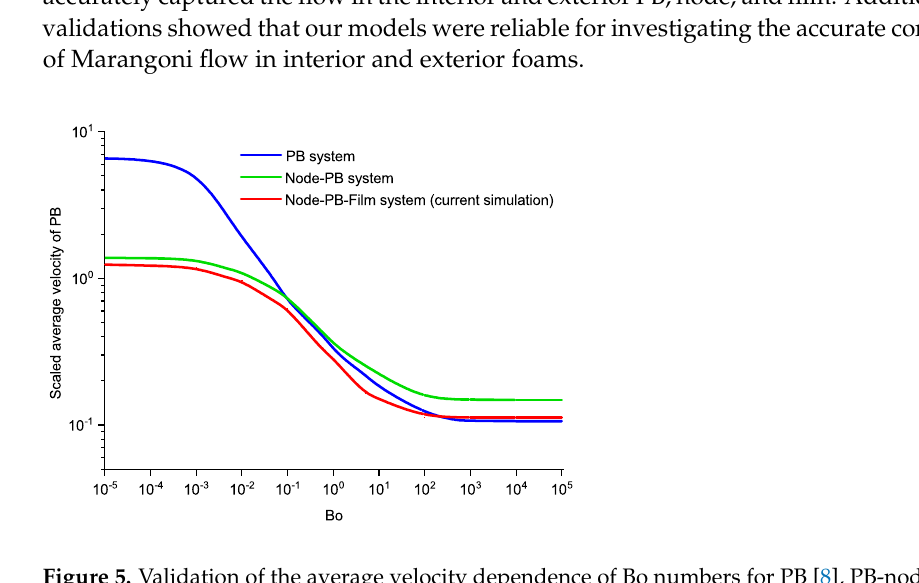
Figure 5. Validation of the average velocity dependence of Bo numbers for PB [8], PB-node [27], and node–PB–node